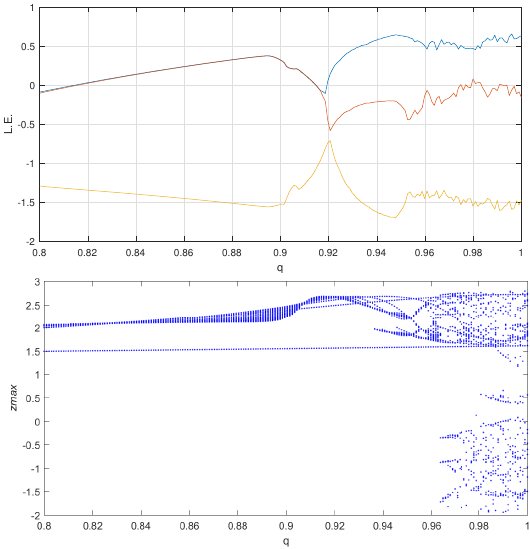
Figure 4. Dynamics of (2) for 0.8 ≤ q ≤